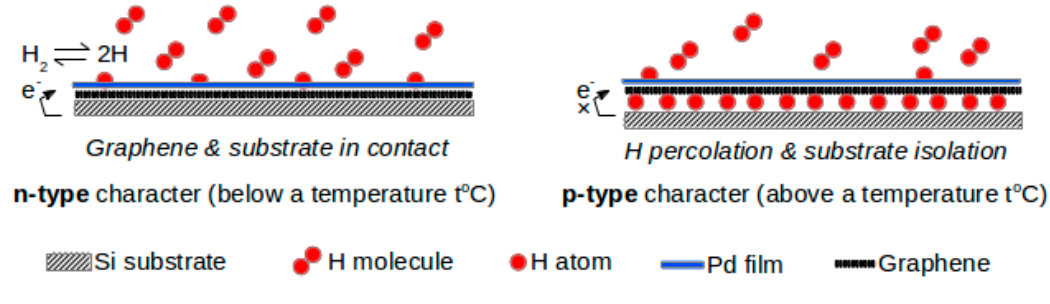
Figure 8. Hydrogen sensing by the hydrogen intercalation mechanism (Reprinted (adapted) with permission from [40] Copyright © 2017, Springer).